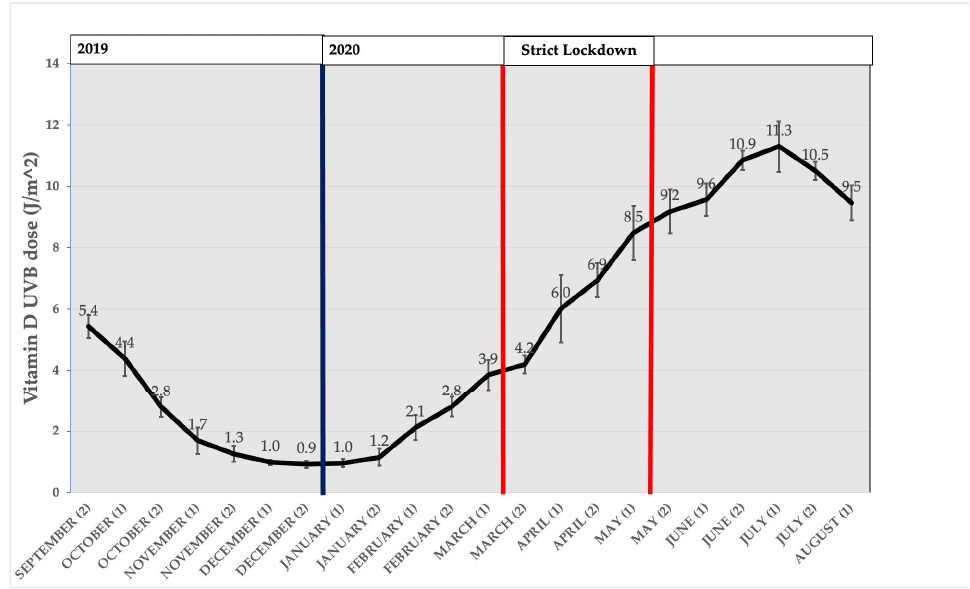
Figure 1. Distribution of vitamin D UVB dose (J/m 2 ) by fortnight from September 2019 to August 2020, summarised as the mean of the days in each fortnight. Bars represent 95%CI. Dark blue bold vertical line represents the beginning of year 2020. Red bold vertical lines represent the beginning and the end of strict lockdown.